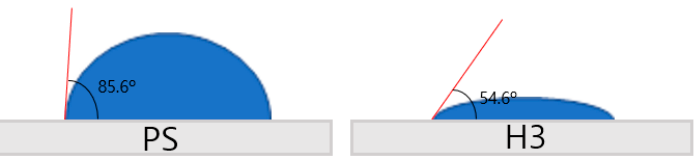
Figure 5. Transmittance spectra of the L, M, and H groups. The transmittance is highest in the H group and in the films with three coatings in any group.